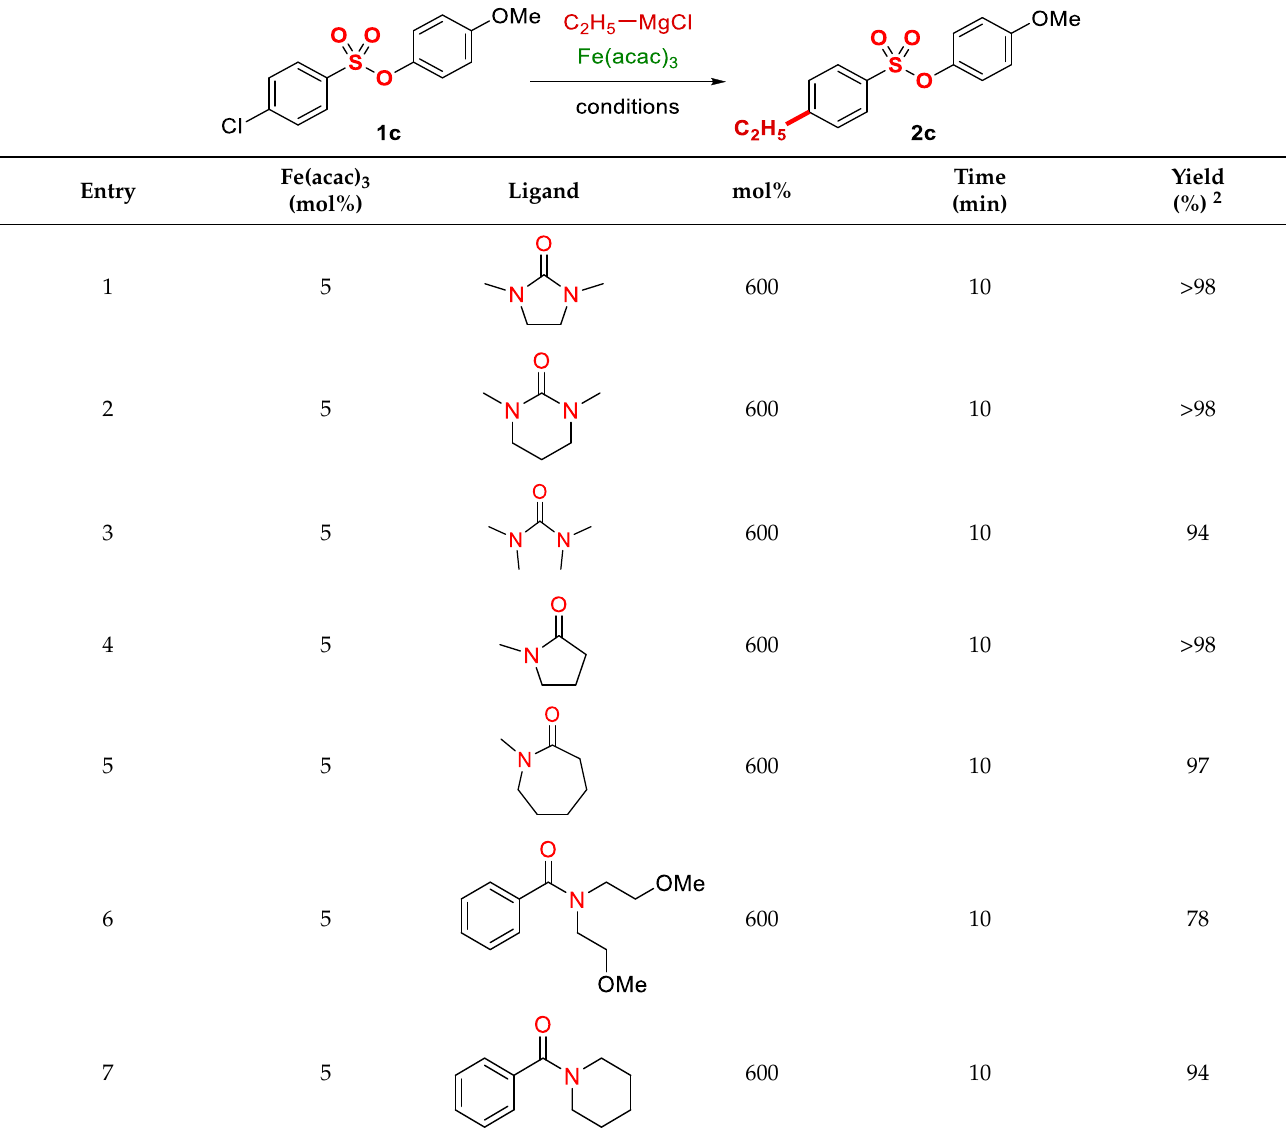
Table 3. O-Coordinating ligand effect on iron-catalyzed cross-coupling of aryl chlorobenzenesulfonates 1 .